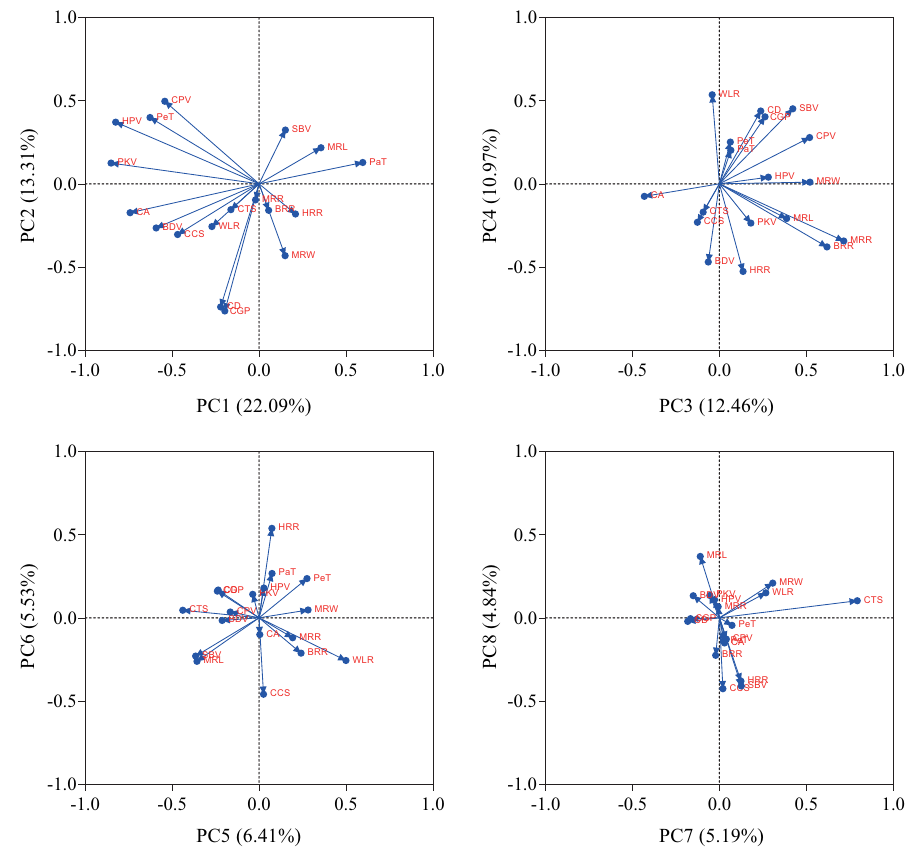
Figure 4. Loadings of top 8 principal